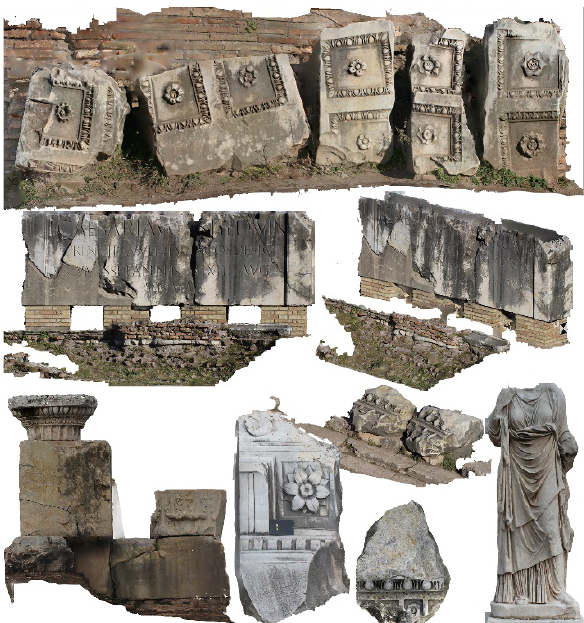
Figure 4: Some of the pieces selected and digitized within the central archaeological area of Rome. From the three-dimensional models we have extrapolated the orto-photos, in order to have a greater awareness of the dimensional comparative aspects.